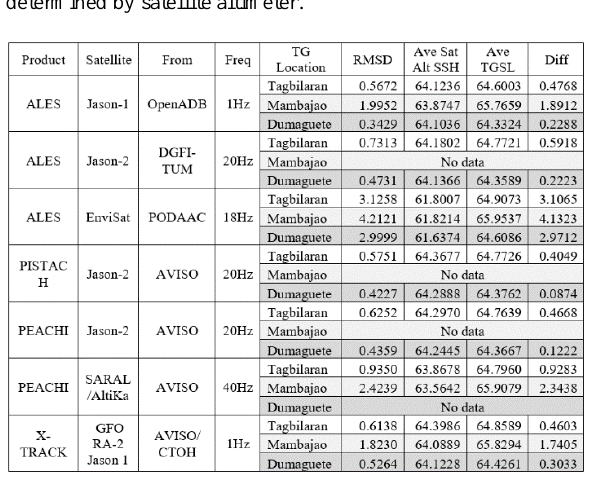
Table 3: Results of sea level comparisons between satellite altimeter and tide gauge data (in